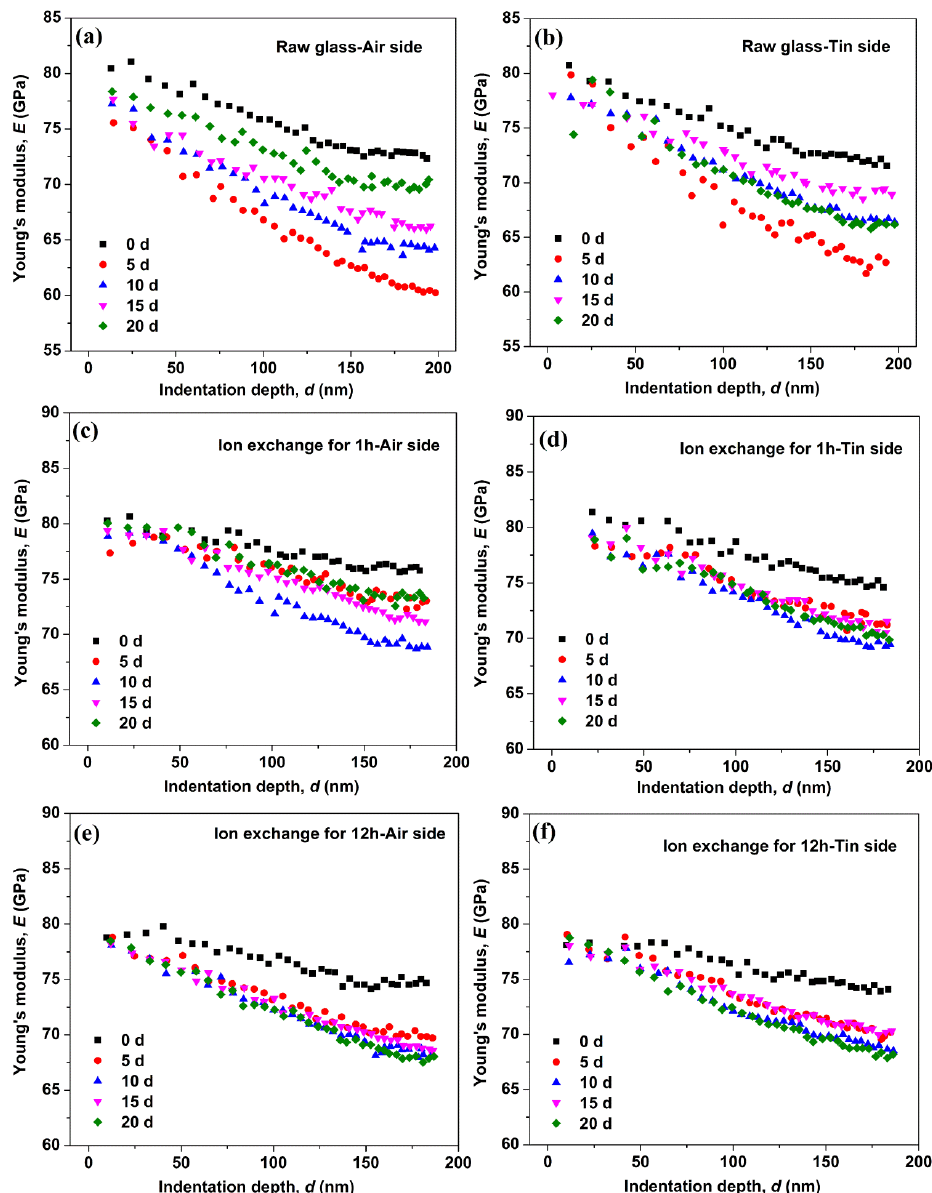
Figure 4. Young’s modulus as a function of the indentation depth on the air side of the raw glass ( a ), on the tin side of the raw glass ( b ), on the air side of the ion-exchanged glasses for 1 h ( c ), on the tin side of the ion-exchanged glasses for 1 h ( d ), on the air side of the ion-exchanged glasses for 12 h ( e ), and on the tin side of the ion-exchanged glasses for 12 h ( f ). Water can exist in glass as a hydroxyl group (Si–OH) or as interstitial molecular wa- ter. A stretching vibration bond of O–H in Si–O–H species can be found at approximately 3662–3697 cm − 1 , and O–H stretching vibrations of liquid-like molecular water (H 2 O) can be found at approximately 3400 cm − 1 , shown as a broad peak [29–31]. Therefore, the IR spectra of 3300–4000 cm − 1 for the raw glass and ion-exchanged glasses are obtained and shown in Figure 5, to investigate the structure variation in glass surfaces caused by hy- dration.